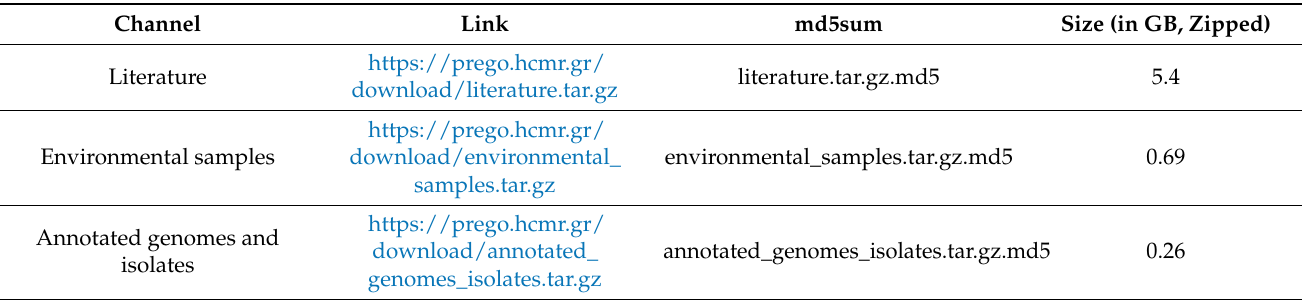
Table A2. Bulk download links and md5sum